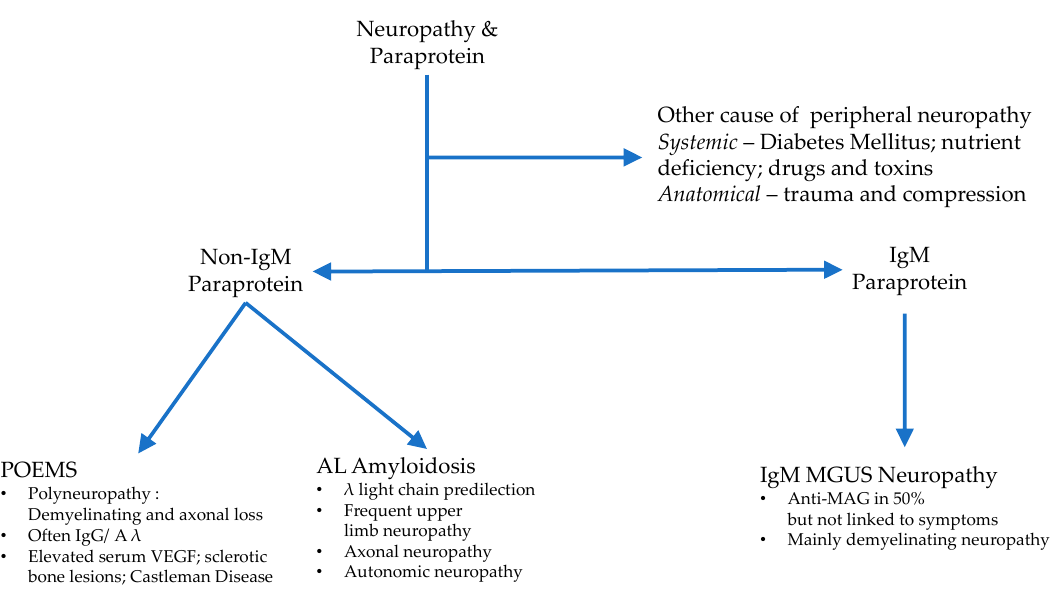
Figure 1. Initial clinical evaluation of a patient with a MGUS and peripheral neuropathy. MGUS = Monoclonal Gammopathy of Undetermined Significance; POEMS = Polyneuropathy, Organomegaly, Endocrinopathy, Monoclonal gammopathy, and Skin changes; VEGF = Vascular Endothelial Growth Factor; AL = Amyloid Light chain; MAG = myelin-associated glycoprotein).